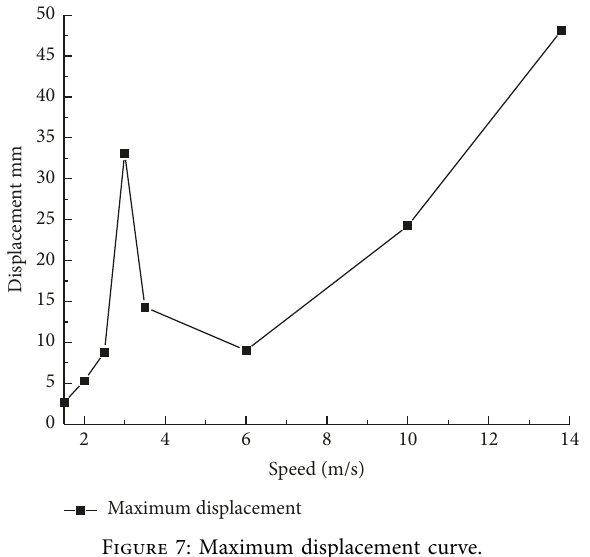
Figure 7: Maximum displacement